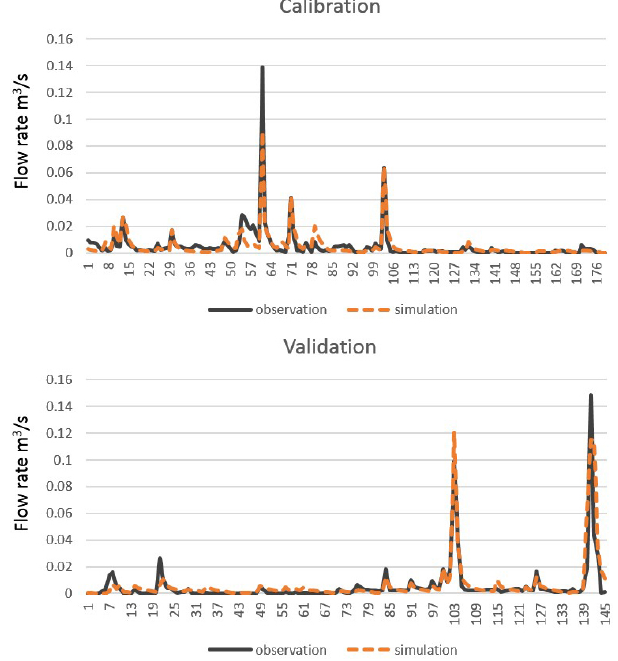
Figure 2. Calibration and validation curve of the river runoff in the IKS catchment.